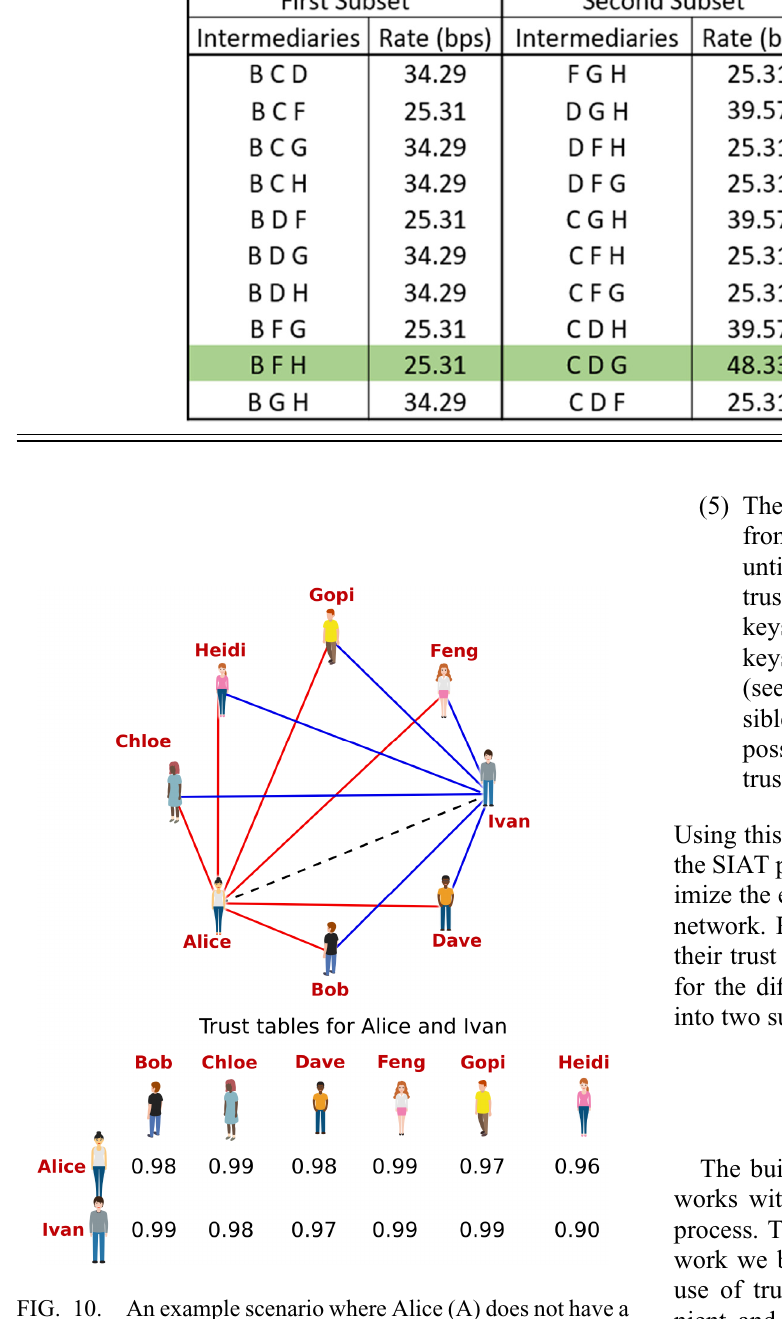
FIG. 10. An example scenario where Alice (A) does not have a preshared authentication key with Ivan (I). Each user has several preshared keys with various other users in the network and the amount of trust Alice or Ivan is willing to place in other users is given in the trust table. All links not shown in this example are currently being utilized for other purposes and are thus not